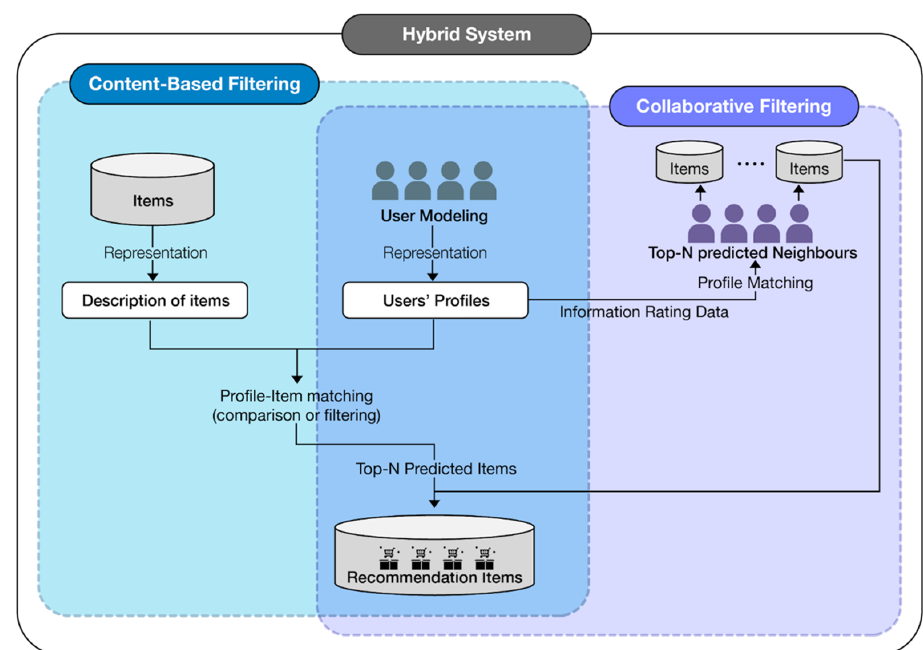
Figure 5 . Process of general recommendation system models. Figure 5. Process of general recommendation system